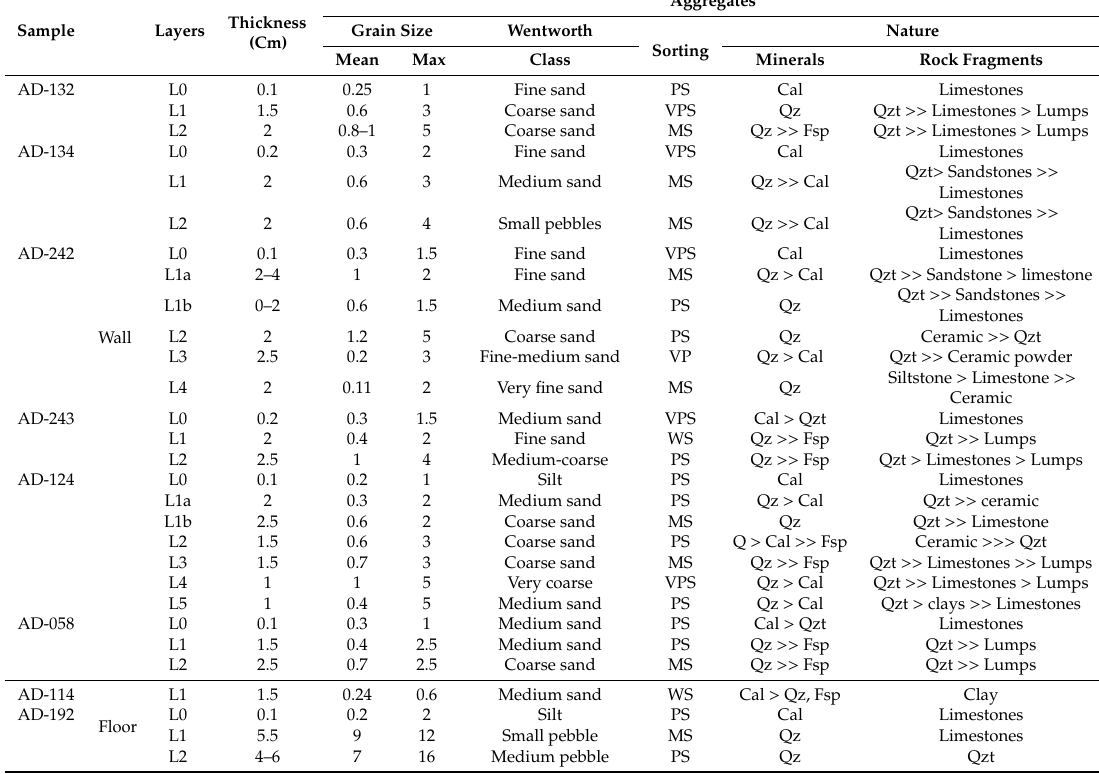
Table 1. Macroscopic and petrographic characteristics of the